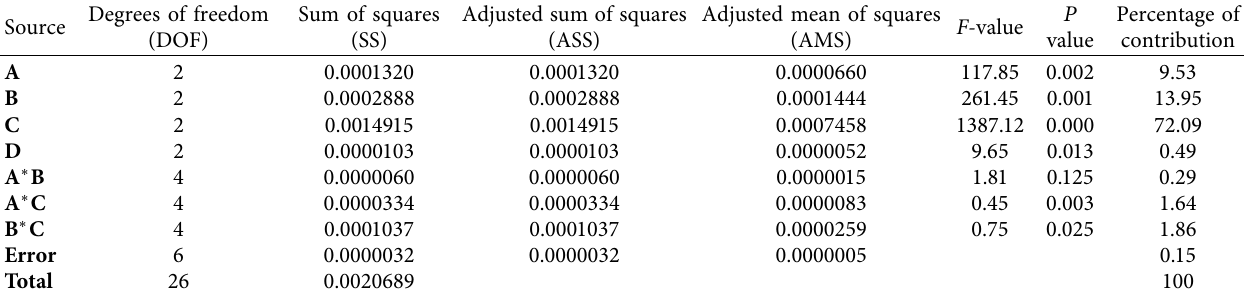
Table 6: ANOVA for wear loss, using adjusted SS for tests.